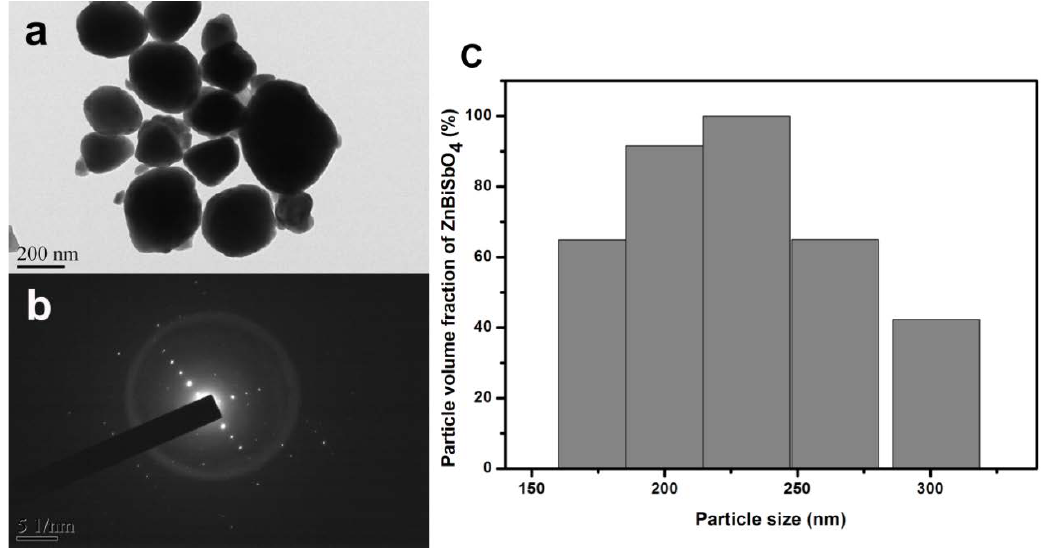
Figure 1. ( a ) transmission electron microscopy (TEM) image of ZnBiSbO selected area electron diffraction pattern of ZnBiSbO calcinated at 800 °C for 35 distribution of ZnBiSbO 4